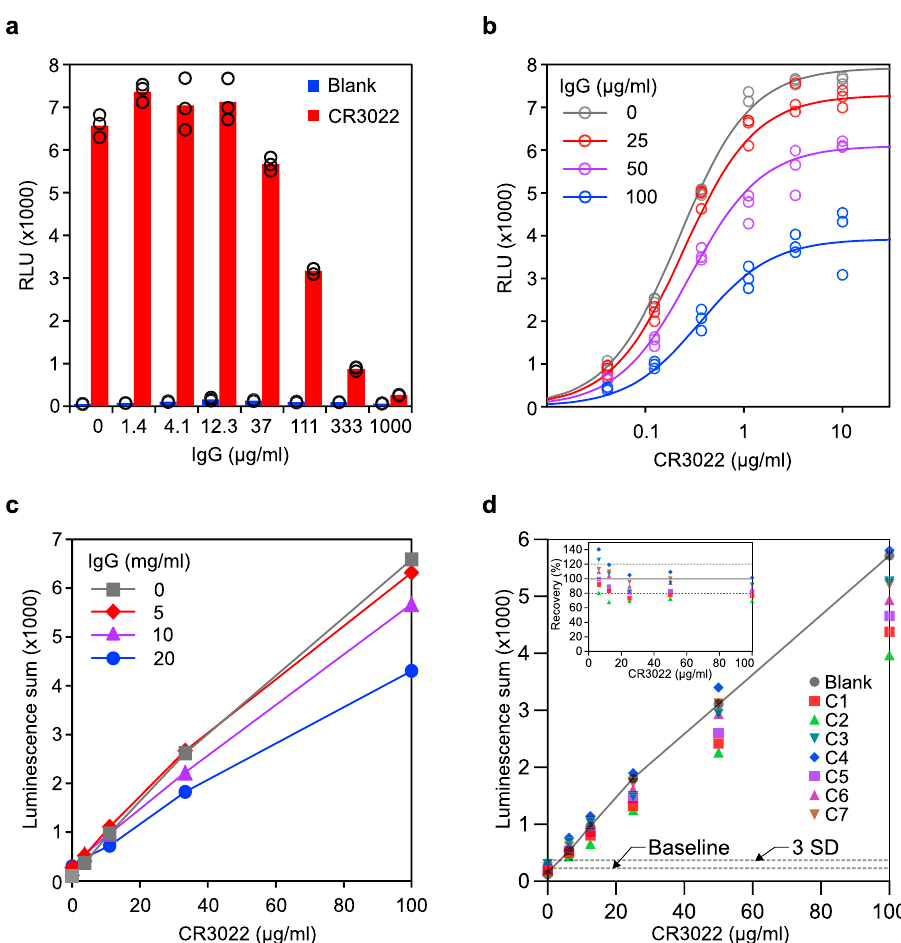
Fig. 2 Characterization of SATiN assay. a Inhibitory effect of additional IgG was examined using dose response. Different amounts of human IgG (as indicated) were applied to samples containing 2 µ g/mL CR3022 (red) followed by analysis with the SATiN assay. Samples without CR3022 (blue) were used as negative control. Data shown here are a representative result of three independent experiments with similar results. b Inhibition kinetics of IgG in the assay were examined with different doses of CR3022, without IgG (gray) or in presence of human IgG at 25 (red), 50 (purple), or 100 (blue) µ g/mL, roughly the amounts in human serum at a 1:200 dilution. Data shown here are a representative result of two independent experiments with similar results. c To mimic serum samples, different amounts of CR3022 (100, 33, 11, or 3.7 µ g/mL) were spiked into buffer containing background human IgG at concentrations of 5 (red diamond), 10 (purple triangle), or 20 (blue circle) mg/mL, or without IgG (gray square). Each sample was serially diluted and then analyzed with the SATiN assay. Sums of luminescence readings at 1:300, 1:900, and 1:2700 for each sample are presented. Data shown here are a representative result of two independent experiments with similar results. d Serially diluted CR3022 (100, 50, 25, 12.5, and 6.25 µ g/mL) was spiked into serum samples ( n = 7, C1 – C7 labeled with different colors and shapes) collected before the pandemic. In blank samples (gray circle), CR3022 was tested in buffer without mixing with serum. Each sample was tested and analyzed as in c . Basal value (baseline) was calculated as the mean of the seven serum samples without CR3022 spiking. The line of standard deviation (SD) × 3 is highlighted as the limit of detection. Recovery is calculated as the percentage signal of a sample divided by the corresponding blank sample and is plotted in the inset. Data shown here are a representative result of two independent experiments with similar results. Source data are available in the Source Data fi